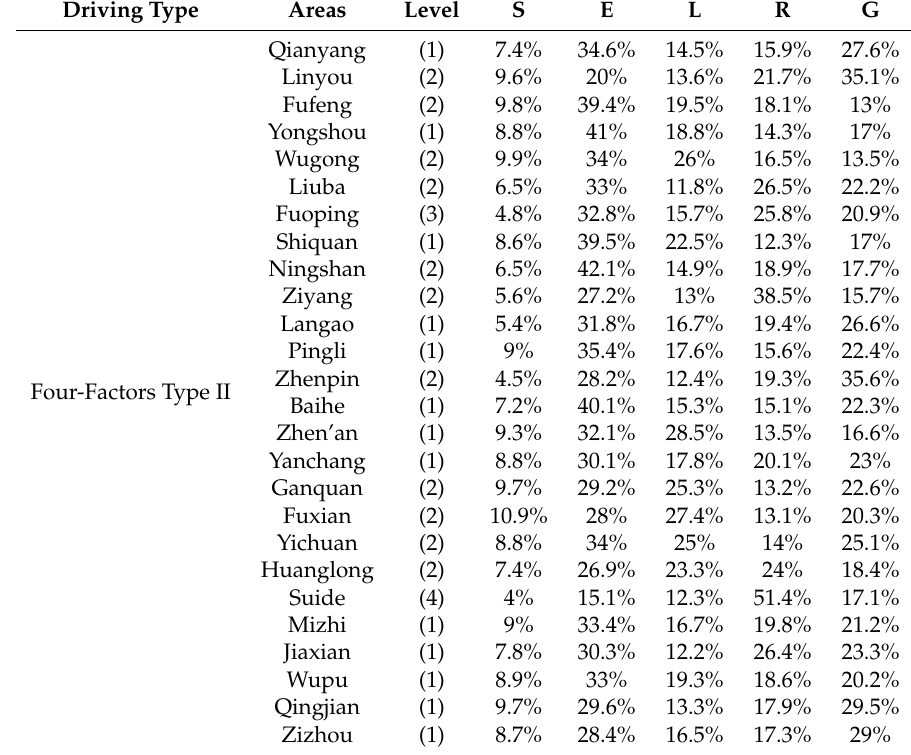
Table 10. Contribution rate of green development driving e ff ect of “Four-Factors Type II” areas. Driving Type Areas Level S E L R G